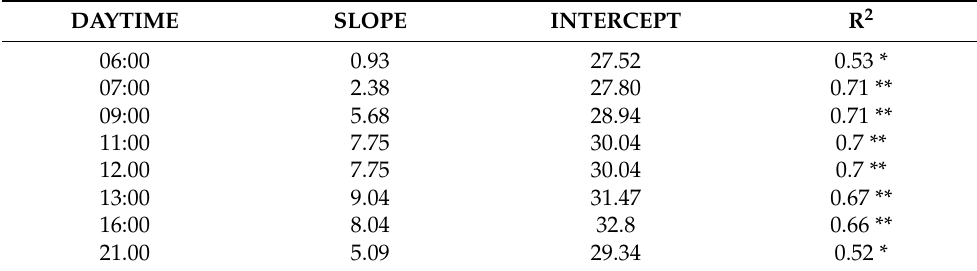
Table 5. Regression parameters of the simple linear regressions between SVF and T air . DAYTIME SLOPE INTERCEPT R 2 06:00